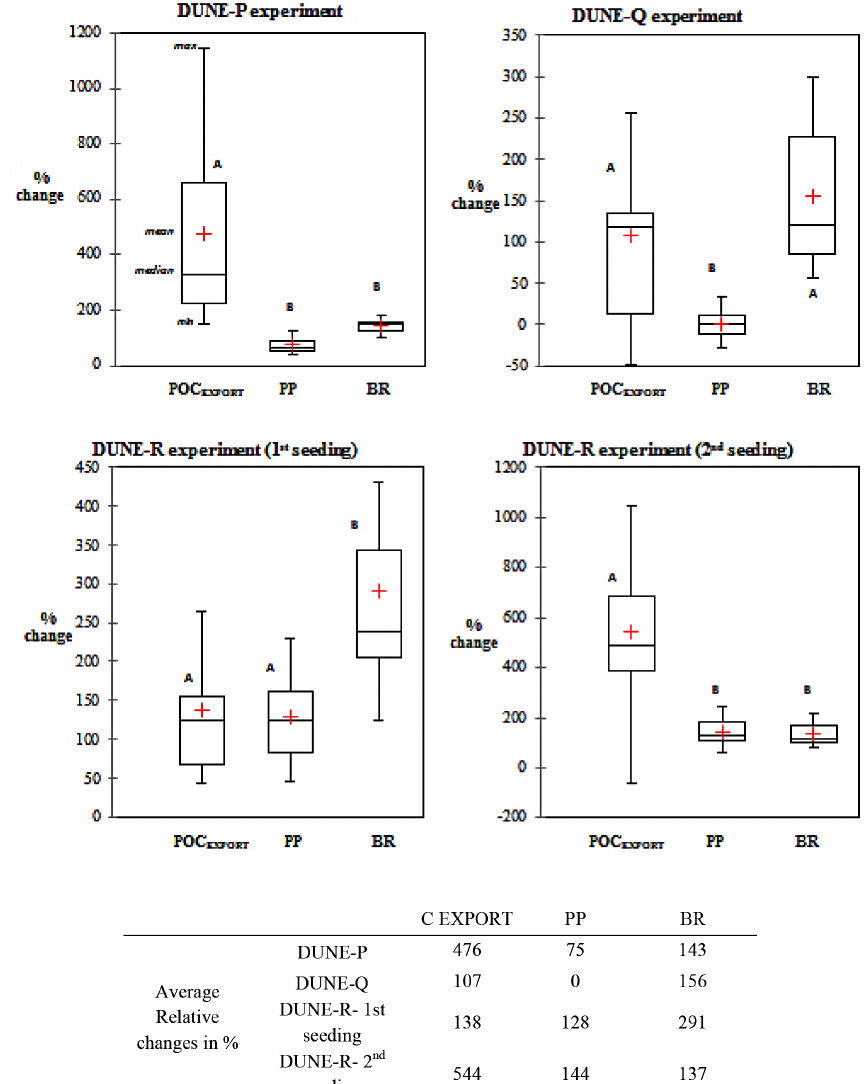
Figure 2. Box plots of the net fluxes expressed in relative change (%) and table with the average relative changes after the DUNE-P, -Q, -R1 and -R2 seedings, in percentage. The letters indicate the results of the statistical test in between the percentage of change for the POC export , PP and BR. Means that were not significantly different between the different parameters ( p > 0.05) were labeled with the same letter. The mean relative changes (RC, in %) = (X Dust –X Control ) × 100/(X Control ) with X Control is the mean for the three mesocosms